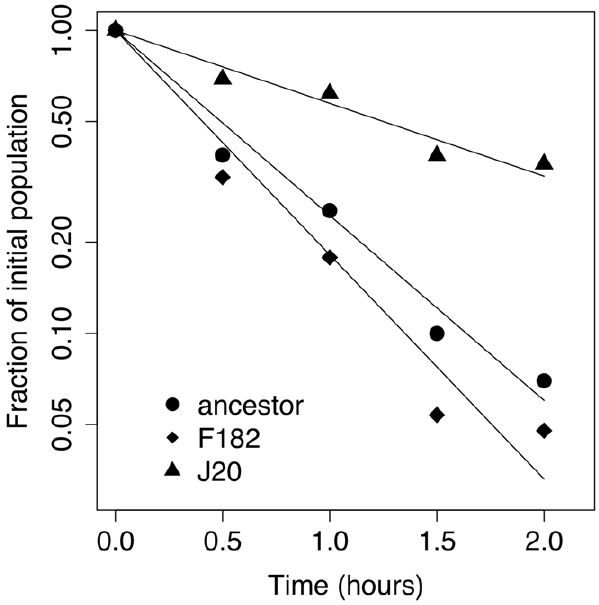
Figure 4. Example decay assay showing reduction in phage survival with time at 37 6 C for wildtype and two mutations. Decay rates in Table 1 and Figure 5were calculated by: (i) obtaining decay rate for each day from the slope of the log-transformed data in a linear regression as illustrated in the figure, (ii) dividing each mutant decay-rate by the ancestor rate for that day, and (iii) averaging across days.